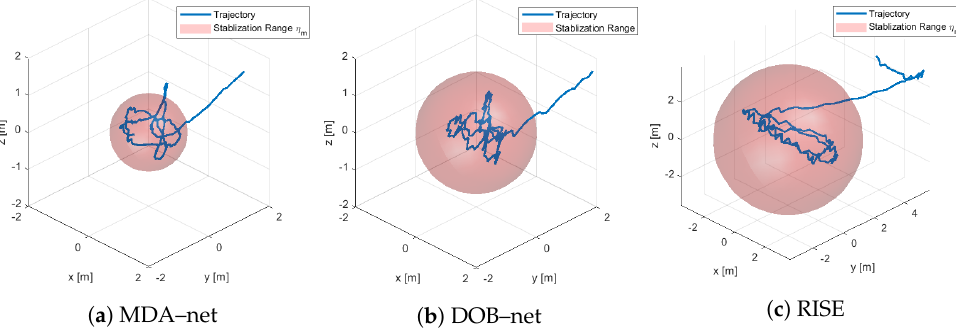
Figure 10. An example of trajectory and position regulation errors from tank tests. The blue curves represent the trajectories from three approaches, and the transparent spheres present stabilization ranges η m defined in Equation (29).